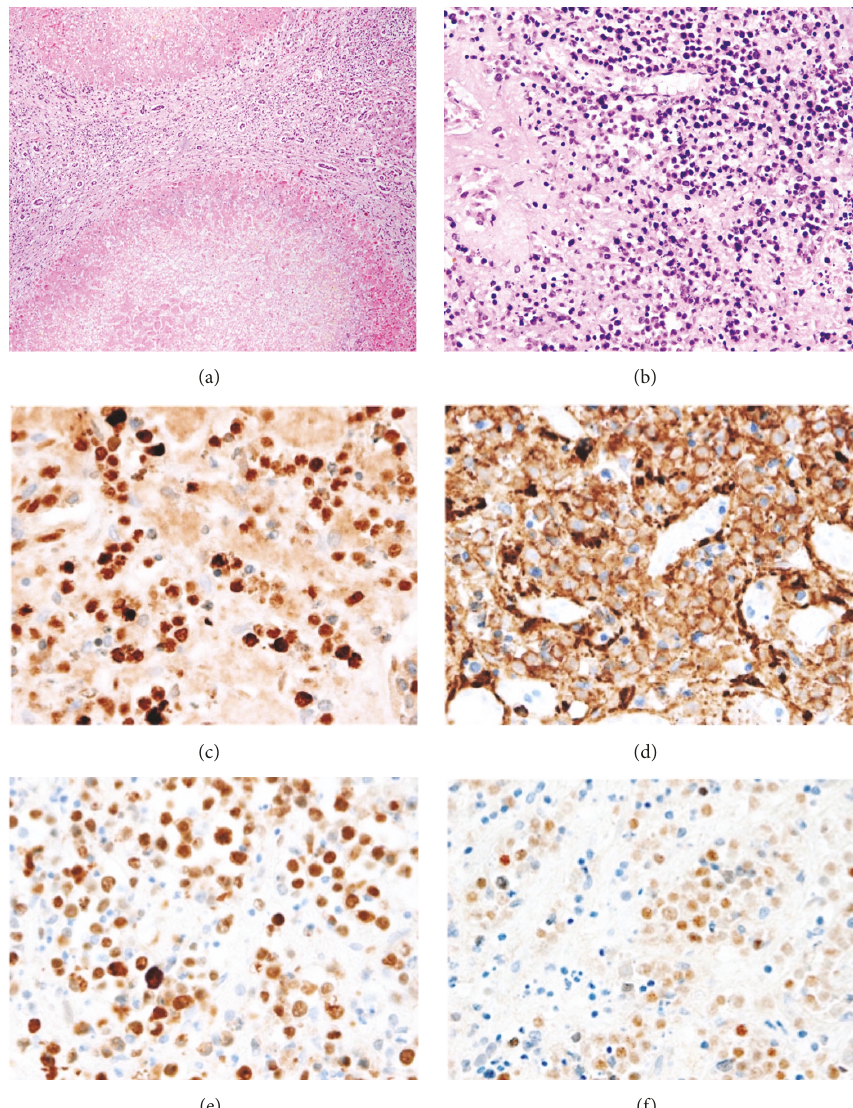
Figure 1: Broad fibrous bands separatenodules of necrotichepatic parenchyma in the setting of cirrhosis (a) and diffuse infiltration of hepatic parenchyma by lymphoma cells admixed with nonneoplastic lymphocytes (b) (H&E); CD10 (c), CD20 (d), and BCL-6 (e) immunostains are strongly and diffusely positive in lymphoma cells; Ki-67 (f) shows a high proliferative index of nearly 100% in malignant cells, which are admixed with nonneoplastic